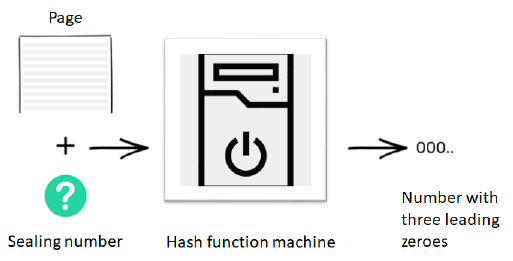
Figure 4. Hash function machine generating sealing number.